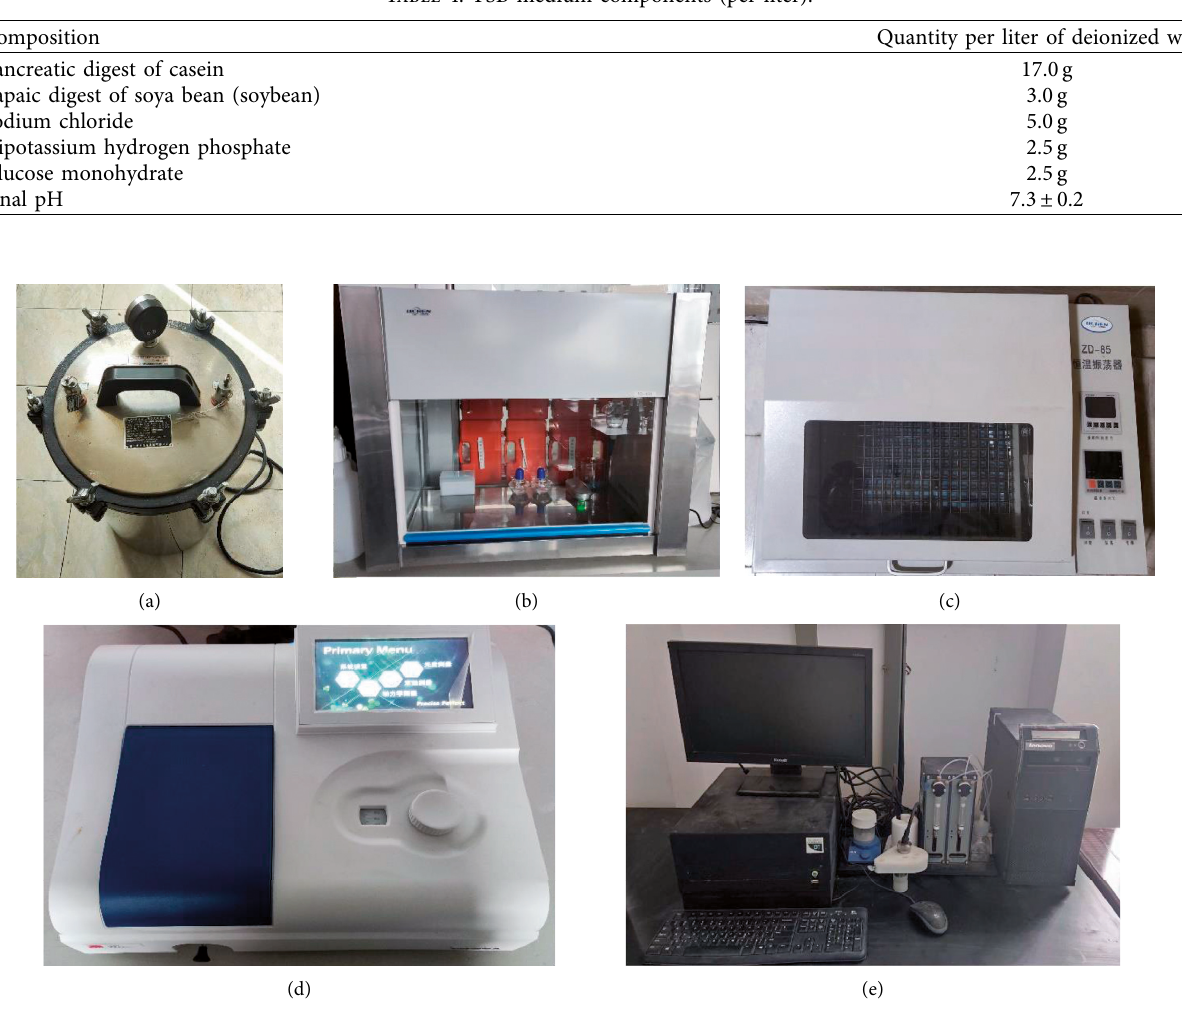
Figure 2: Main instrumentation images: (a) pressure steam sterilizer, (b) clean benche constant, (c)temperature oscillation incubator, (d) spectrophotometer, and (e) acoustic and electroacoustic spectrometer.